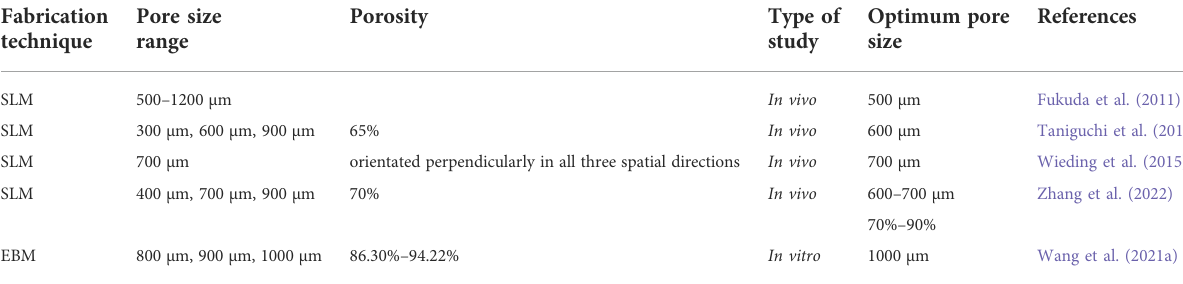
TABLE 1 Porosity and pore size of 3D printed titanium scaffold for bone regeneration (pore size is expressed as range or average pore size). Fabrication